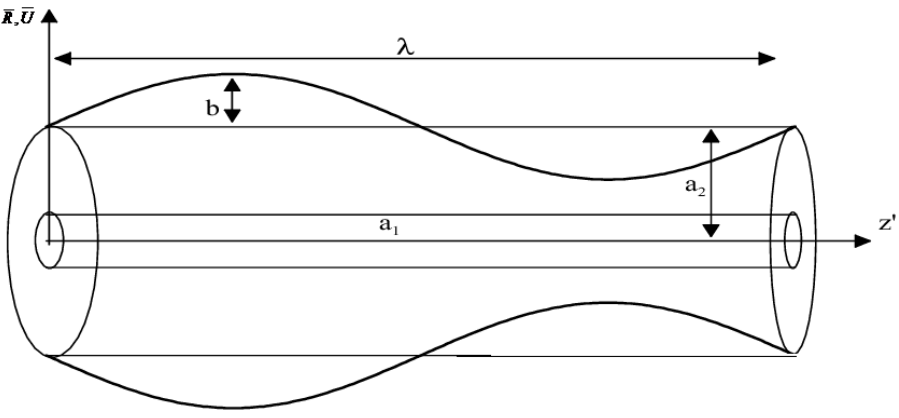
Figure 1. E ff ects of an endoscope on peristaltic Figure 1. Effects of an endoscope on peristaltic motion.